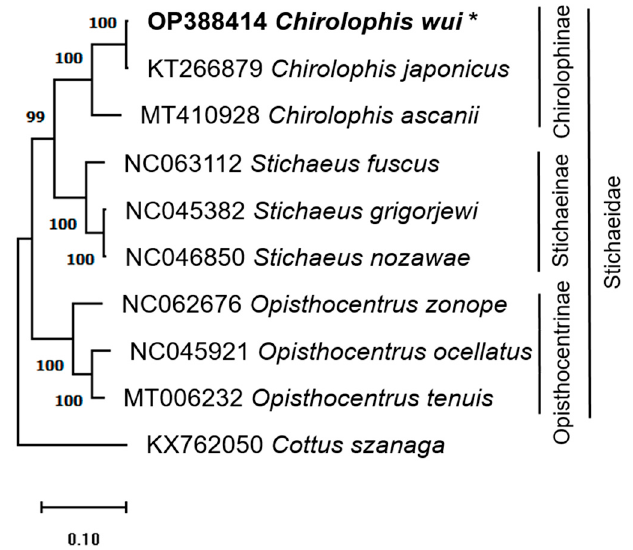
Figure 5. The phylogenetic tree was obtained using the complete mitochondrial genome sequences from ten species (nine from the Stichaeidae family and Cottus szanaga from the Cottidae family as an outgroup) and 1000 bootstrap repetitions using the maximum-likelihood approach. The numbers on the branches represent the bootstrap values, and the star next to Chirolophis wui denotes the species used in this research.